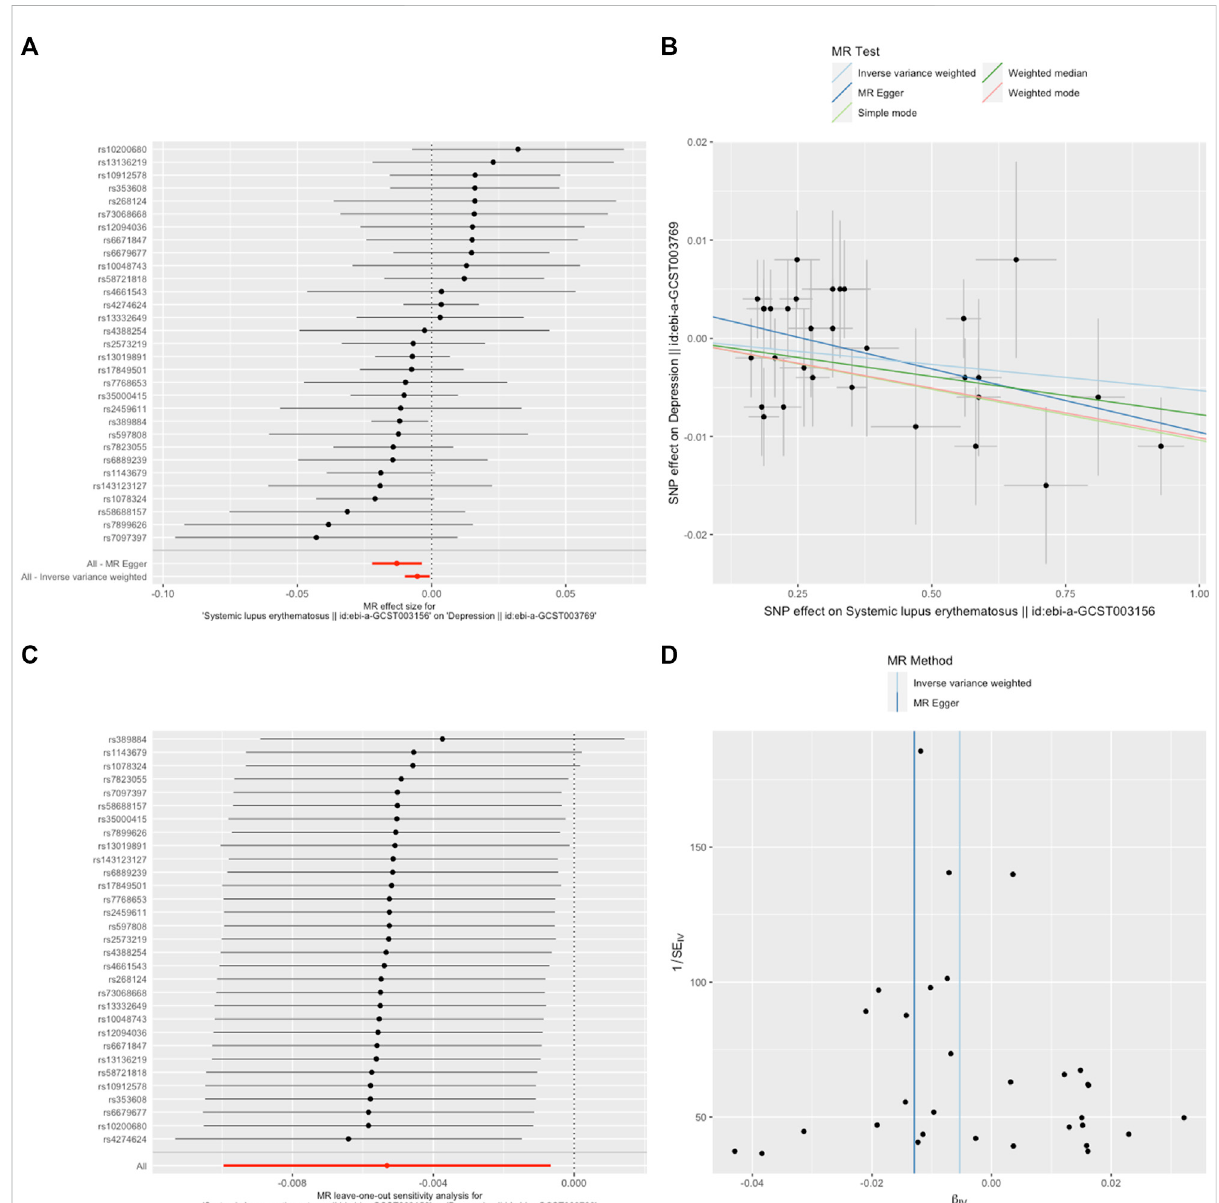
FIGURE 1 SLE decreased the odds of depression. (A) . The forest plot shows the estimate of the effect of genetically increased SLE risk on depression risk, where each black point represents the log odds ratio (OR) for depression per standard deviation (SD) increase in log OR for SLE, and red points showing the combined causal estimate using all SNPs together in a single instrument, using each of the two different methods (inverse-variance weighted [IVW]randomeffects andMR-Egger). Horizontal linesdenote 95%con fi dence intervals (95%CIs). (B) .A plotrelatingtheeffectsizes of the SNP-SLE association (x-axis, log OR) and the SNP-depression associations (y-axis, log OR) with standard error bars. The slopes of the lines correspondtocausalestimatesusingeachofthefourdifferentmethods(weightedmedian,weightedmode,IVWrandomeffectsandMR-Egger) (C) . MRleave-one-out sensitivity analysis for SLEondepression. Eachblack pointrepresentstheIVW MRmethod applied toestimatethecausaleffect of SLE on depression excluding that particular variant from the analysis. The red point depicts the IVW estimate using all SNPs. There are no instances where the exclusion of one particular SNP leads to dramatic changes in the overall result. (D) . Funnel plot showing the relationship between the causaleffectofSLEondepressionestimatedusingeachindividualSNPasaseparateinstrumentagainsttheinverseofthestandarderrorofthecausal estimate. Vertical lines show the causal estimates using all SNPs combined into a single instrument for each of the two different methods (IVW random effects and MR-Egger). There is no signi fi cant asymmetry in the